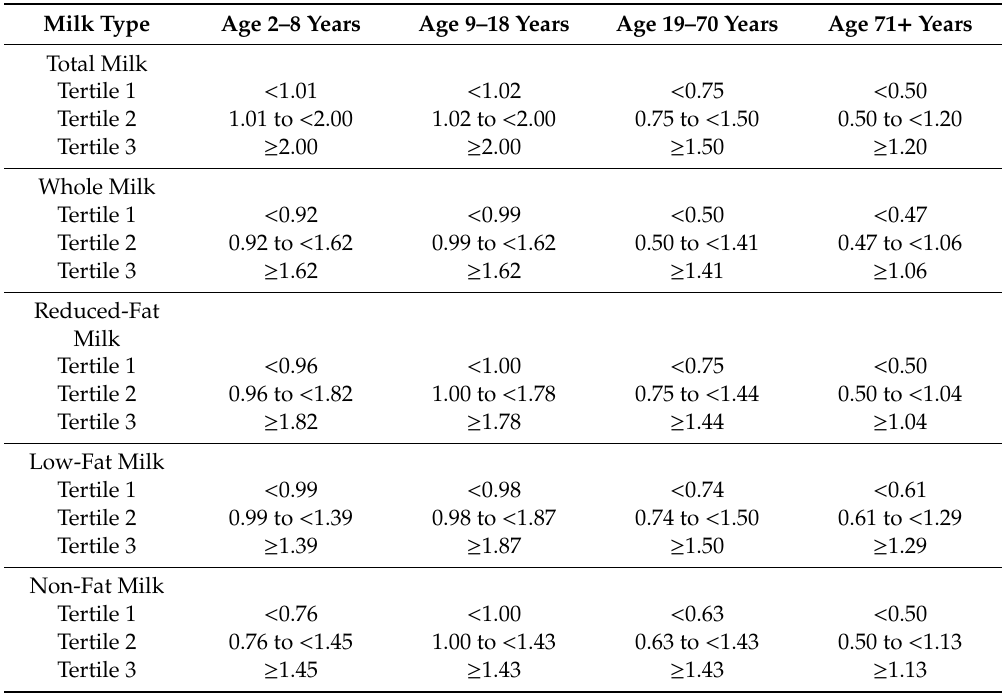
Table 1. Milk intake tertiles (cup eq / day) by milk type in di ff erent age groups, NHANES 2001–2010. Milk